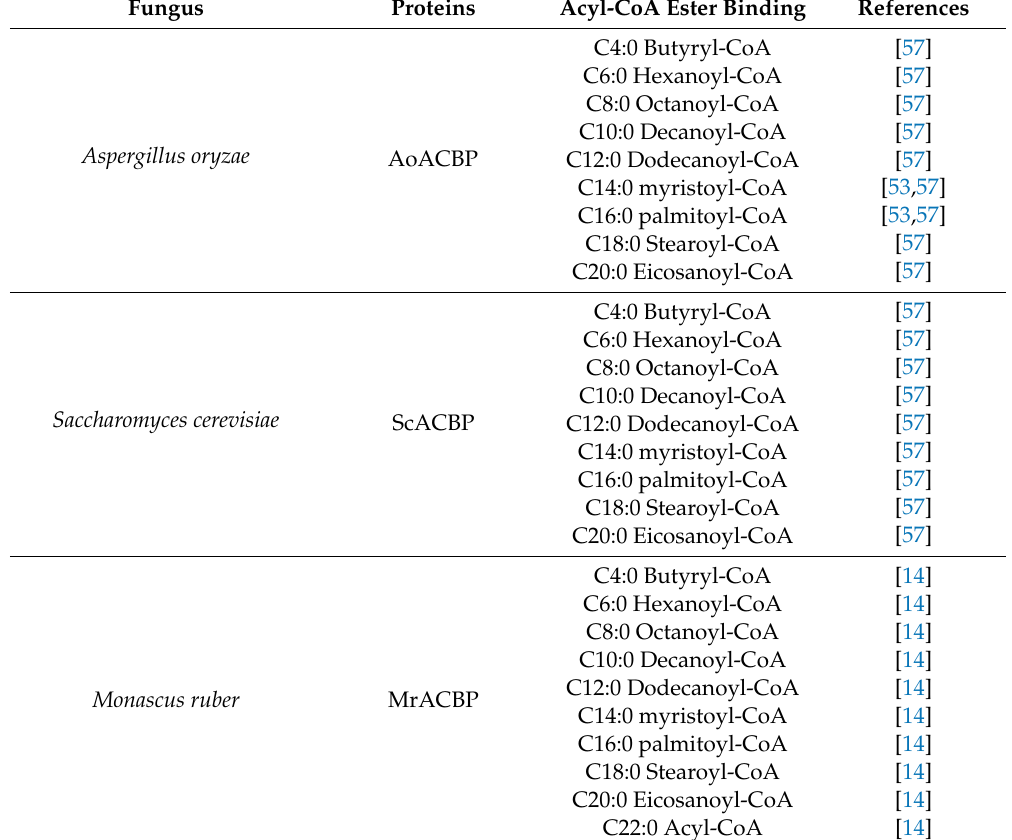
Table 2. Binding Characteristics of ACBP from Filamentous Fungi and Yeast with Acyl-CoA